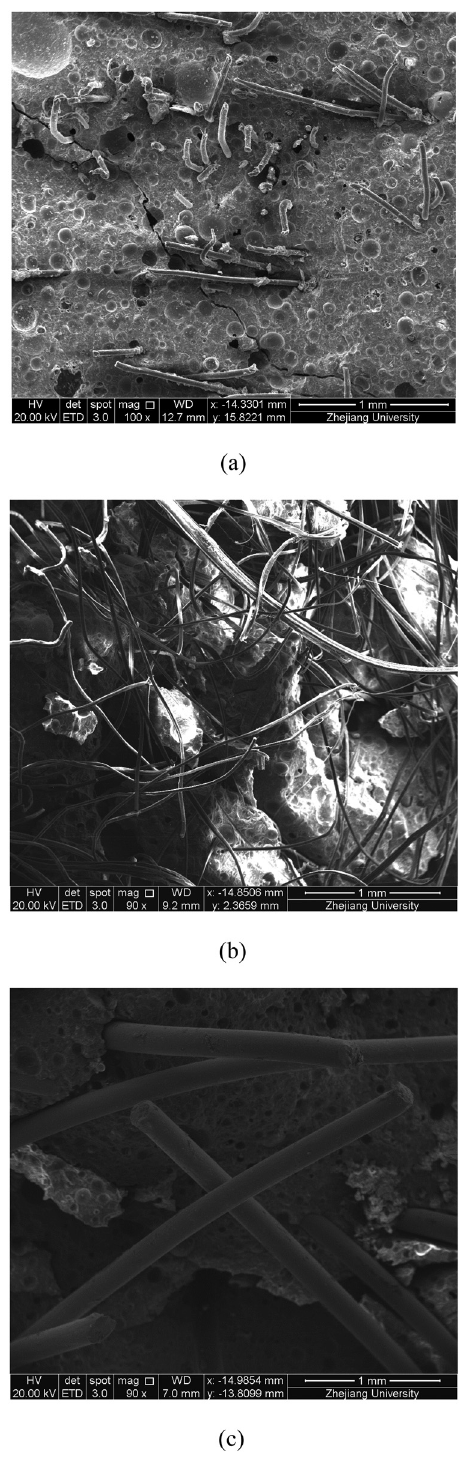
Figure 16: SEM image of the fracture specimen with di ff erent fi ber types. ( a ) PVA; ( b ) PE; ( c )